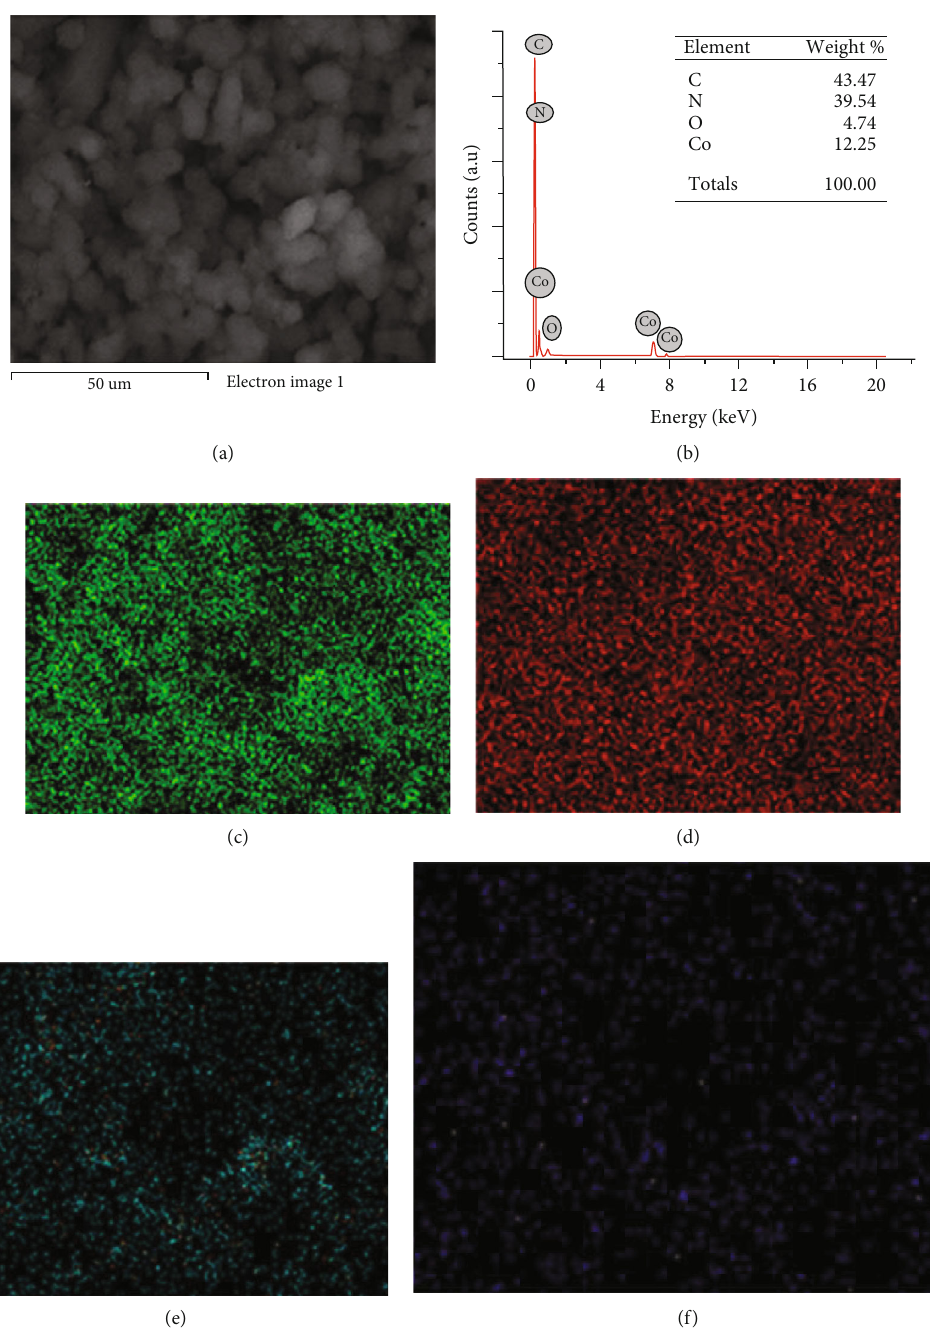
Figure 5: EDX-mapping of electron image for ZIF-67/ g -C oxygen element